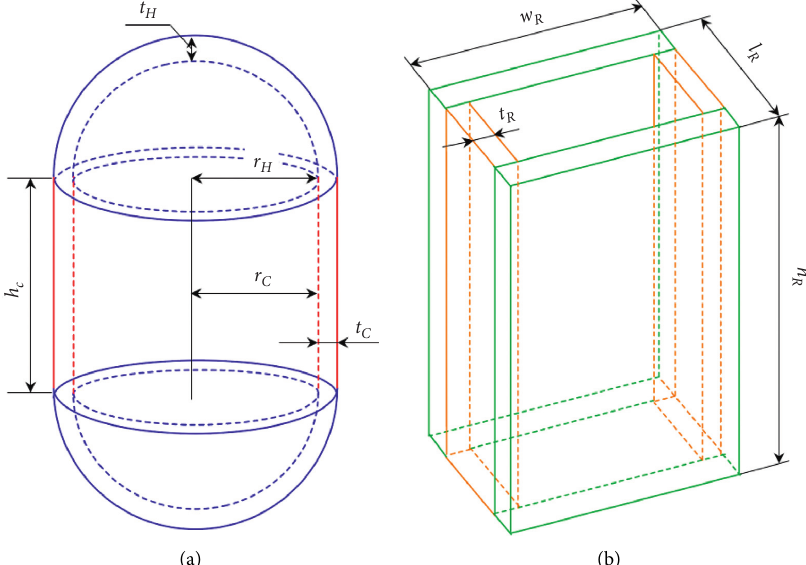
Figure 1: Schematic view of two types of objects representing large metal components: (a) spherocylinder-type object; (b) rectangular prism-type object.